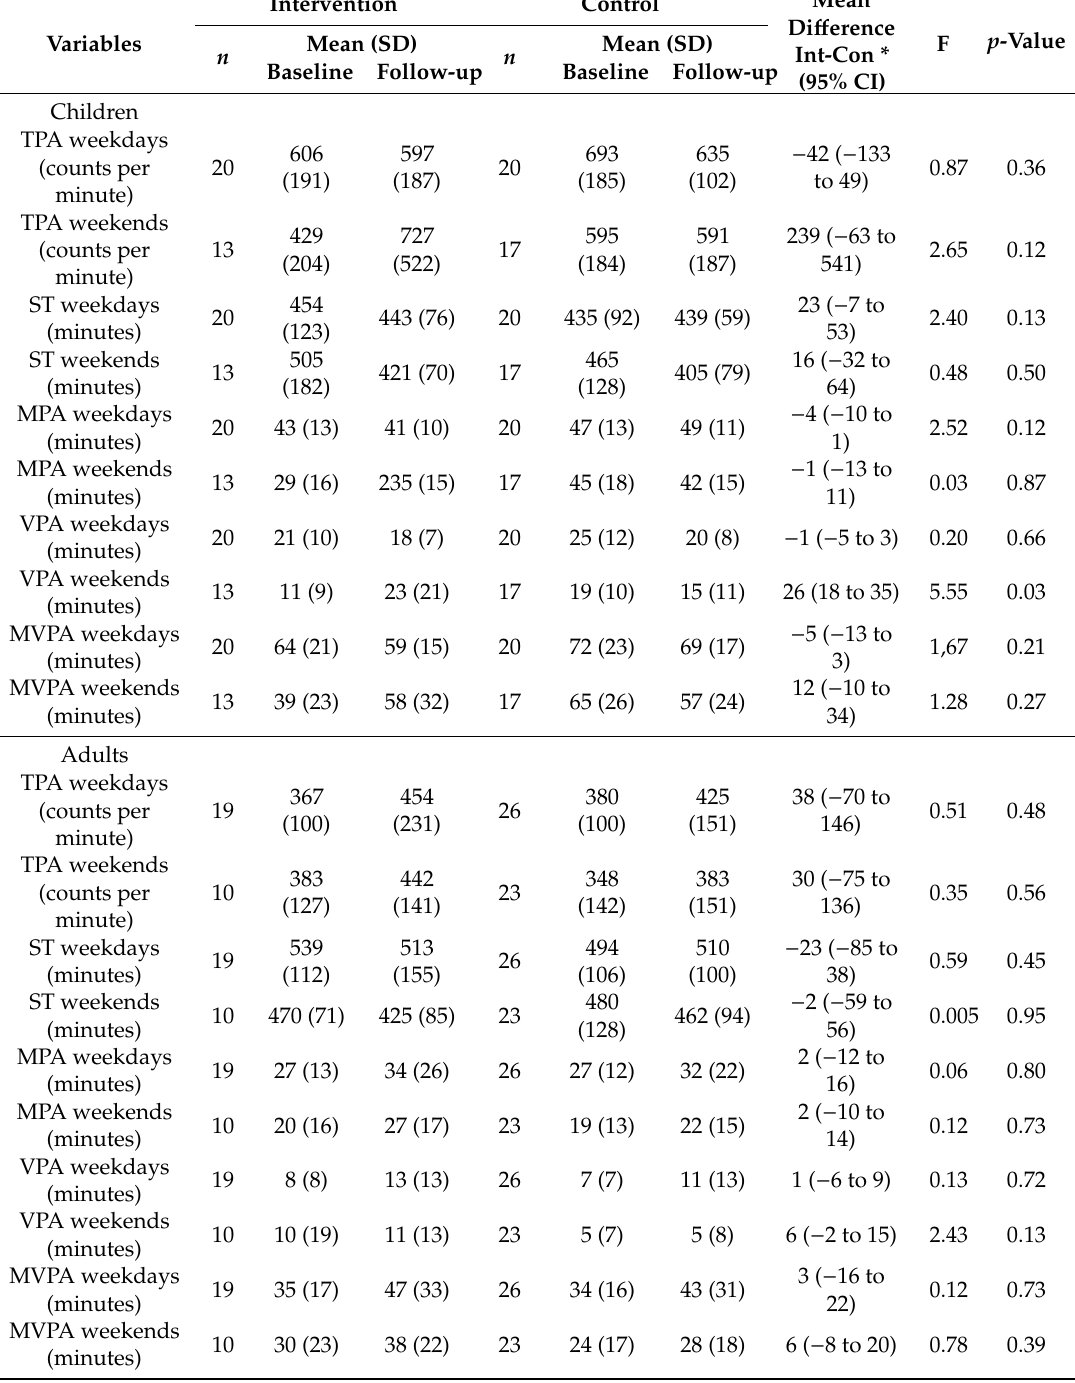
Table 4. Di ff erences between intervention and control groups in physical activity and sedentary time categorized children and